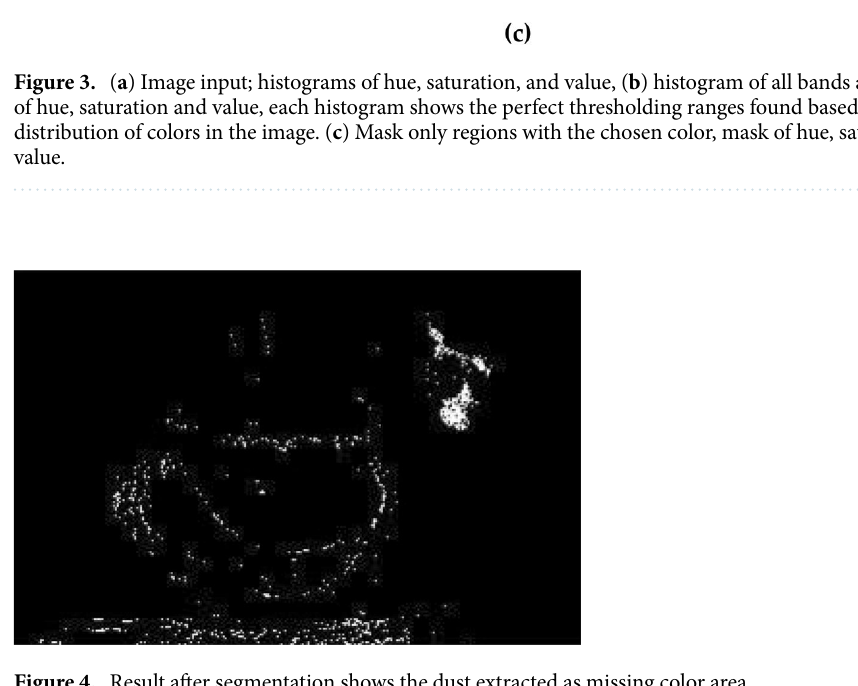
Figure 4. Result after segmentation shows the dust extracted as missing color